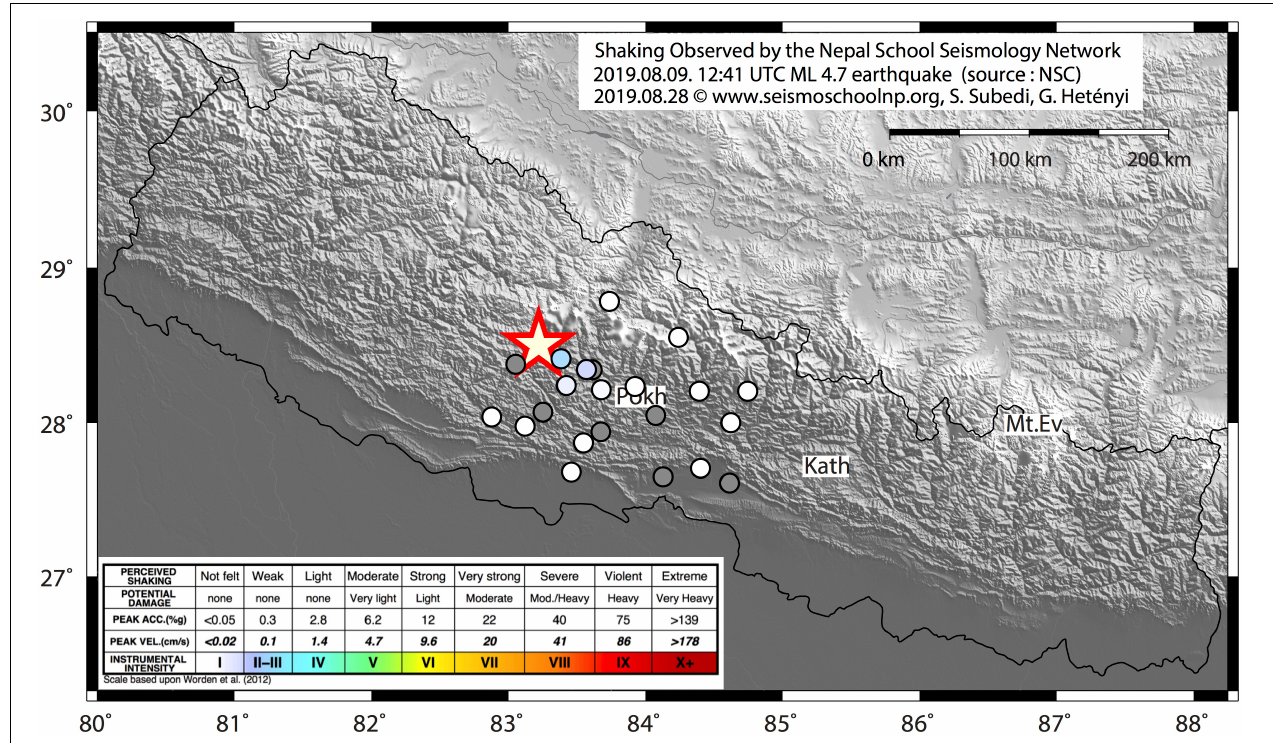
FIGURE 9 | Observed instrumental intensity map from the 2019 August 9 M L 4.7 Myagdi earthquake. The observed intensity data at NSSN stations are plotted in circles and are color-coded according to their value based on Worden et al. (2012) as shown in the legend. Gray color means no data for the event from that station (either no internet or no power supply). The capital city of Nepal, Kathmandu is denoted by Kath , the highest point of the Earth, Mount Everest is denoted by Mt.Ev , and the capital city Pokhara of the Gandaki province is denoted by Pokh